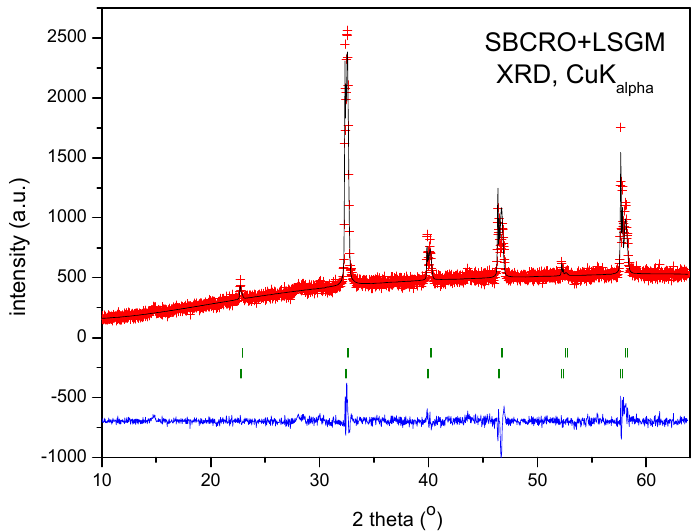
Figure 5. Rietveld refinement from XRD data of a powdered mixture of the La 0.83 Sr 0.17 Ga 0.8 Mg 0.2 O 3 − δ (LSGM) electrolyte and the Sr 0.9 Ba 0.1 Co 0.95 Ru 0.05 O 3 − δ electrode after a thermal treatment in air at 1100 ° C, showing both phases unchanged.